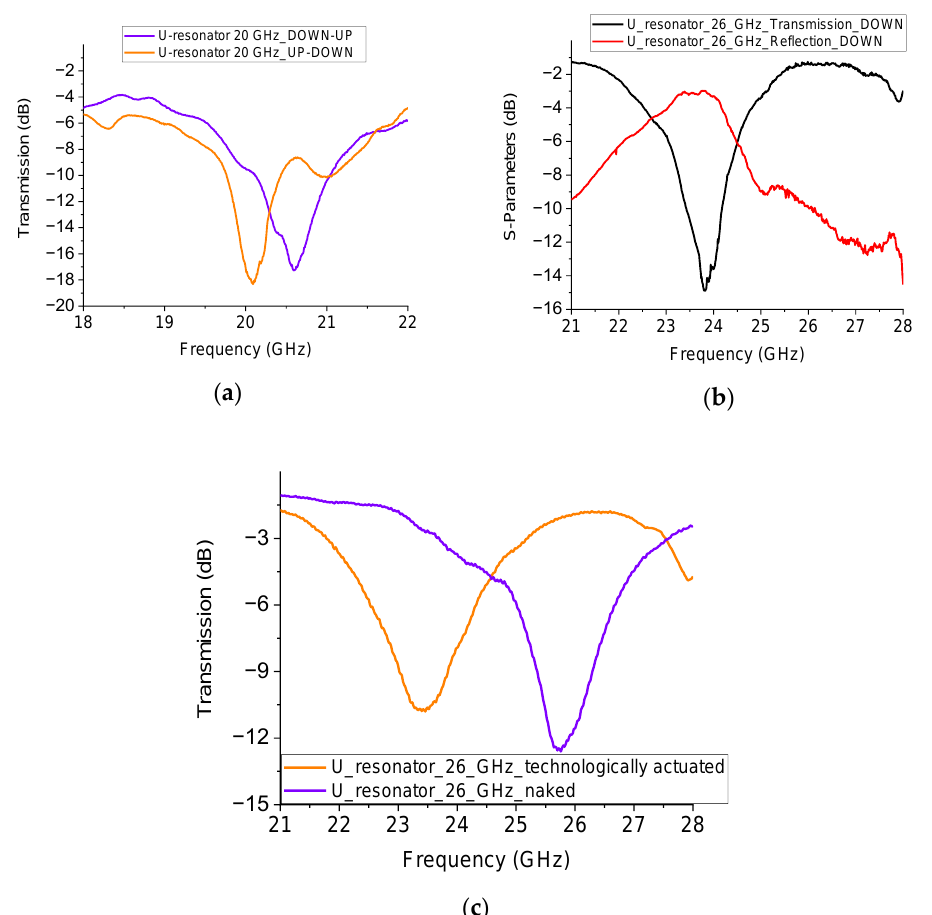
Figure 7. ( a ) The response of the 20 GHz semi-ideal device with technologically actuated switches and responses for the two situations (left or right arm switch actuated, corresponding to the up or down position of the metal beams). ( b ) The response of the 26 GHz resonator when the switch is technologically actuated. ( c ) The technologically actuated switch is compared with the naked one without a switch.